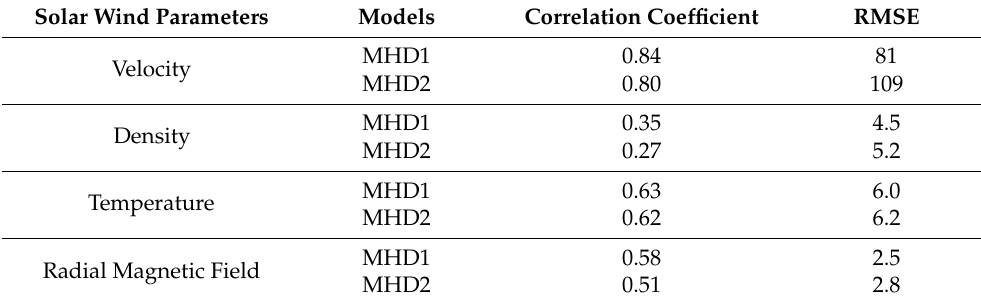
Table 1. Comparison of the solar wind modeling results at 1AU with the observational data from OMNI. Solar Wind